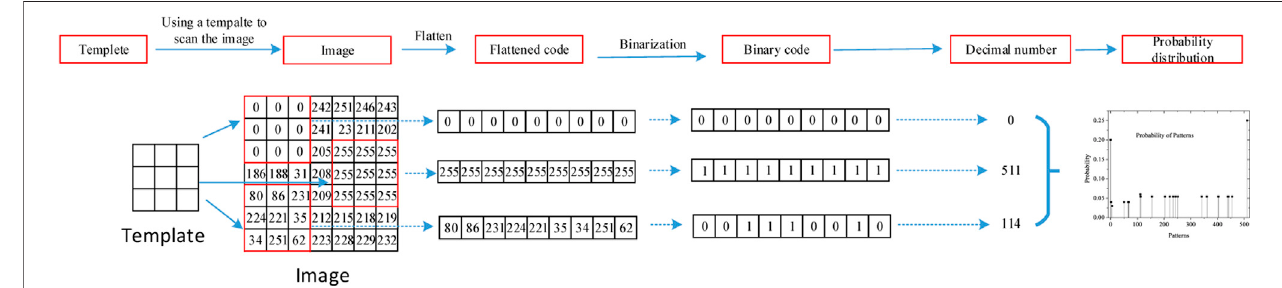
FIGURE 3 | Schematic diagram for the reconstruction stage of